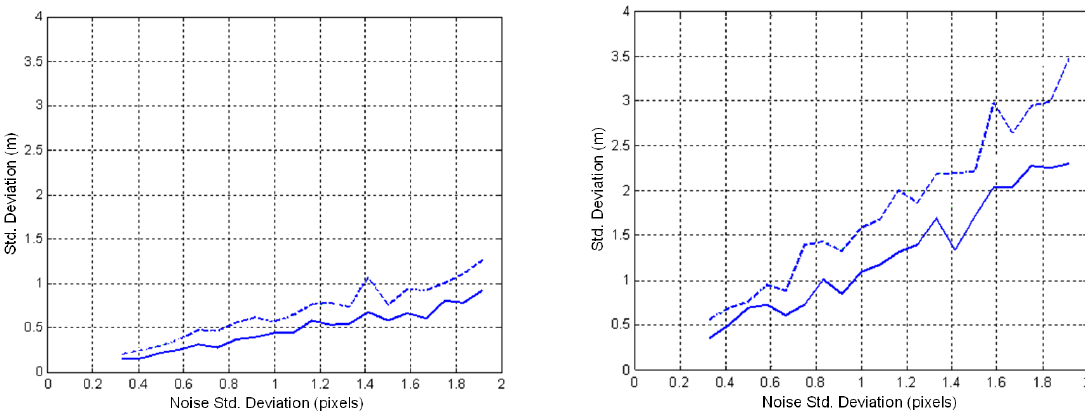
Figure 11. Results of sensitivity analysis in homography-based (left) and terrain projection (right)